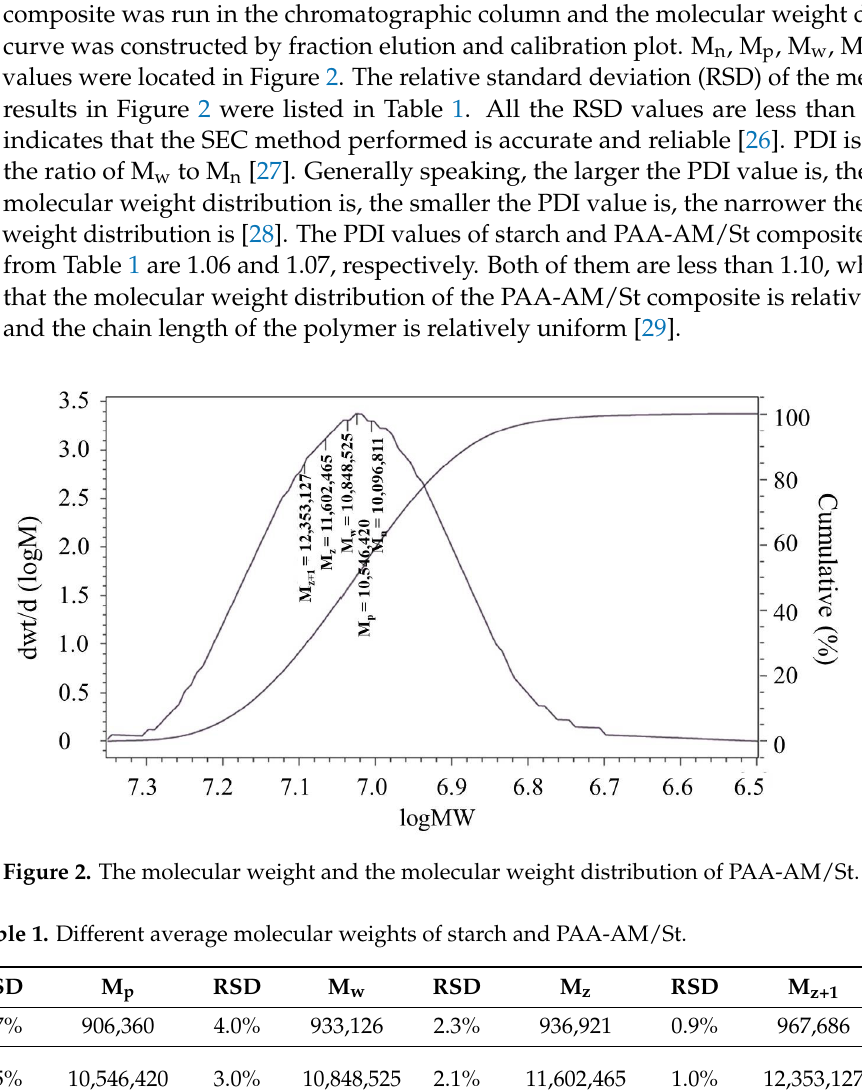
Figure 1. Schematic illustration of polymerization .